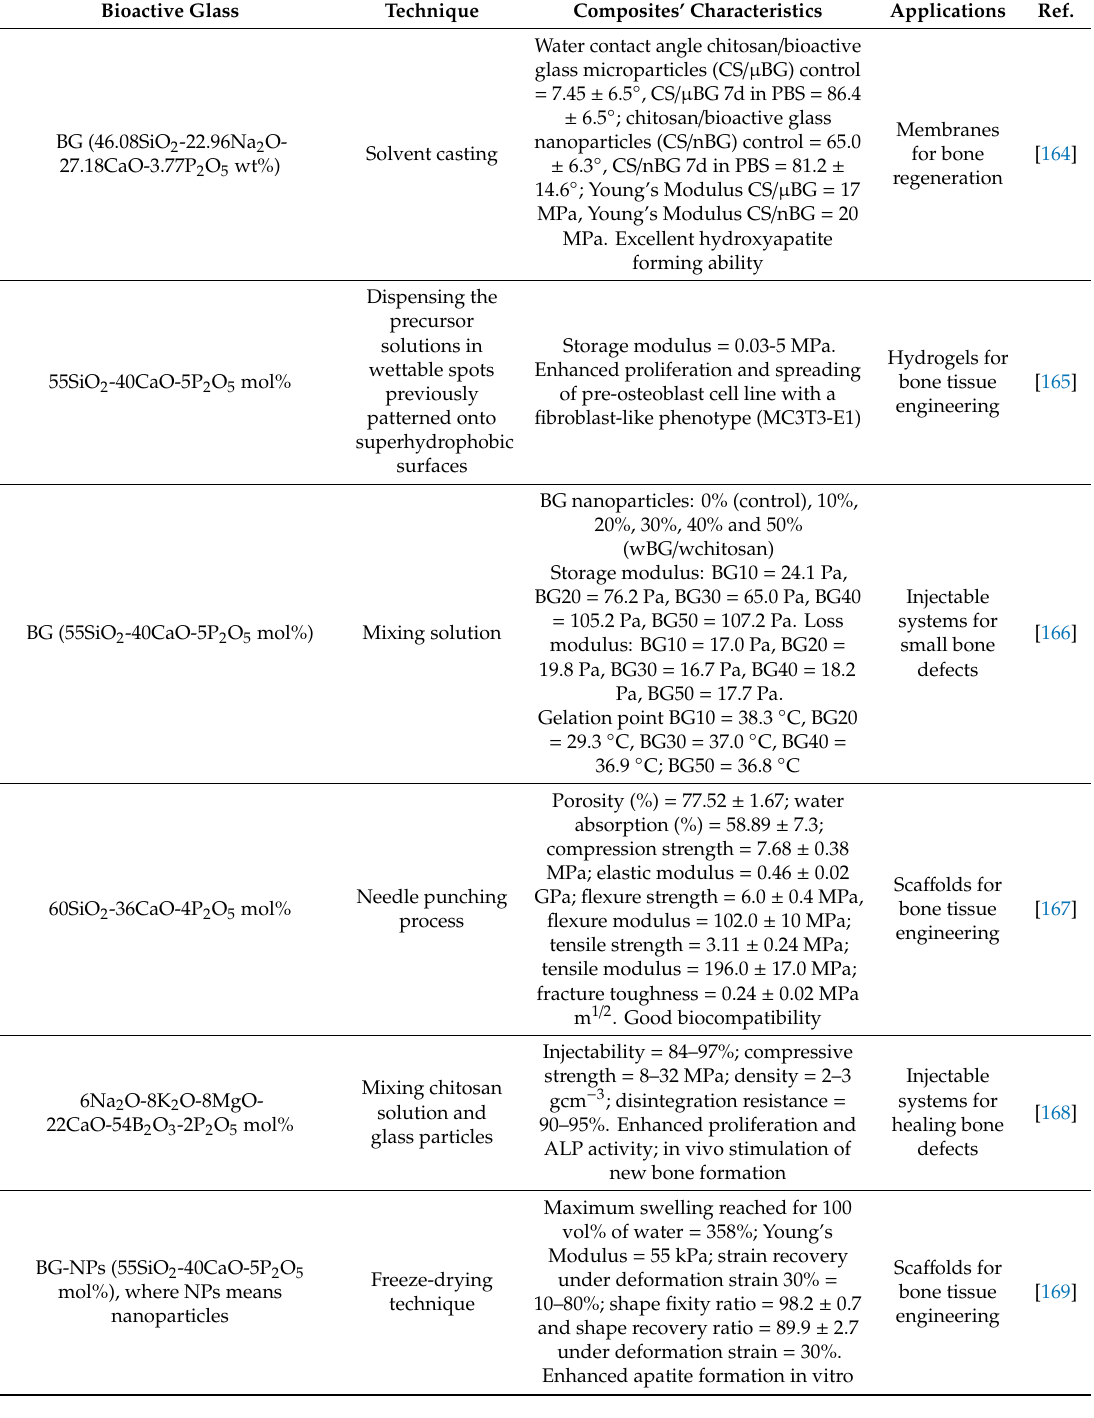
Table 5. Summary of chitosan / bioactive glass composites for hard and soft tissue